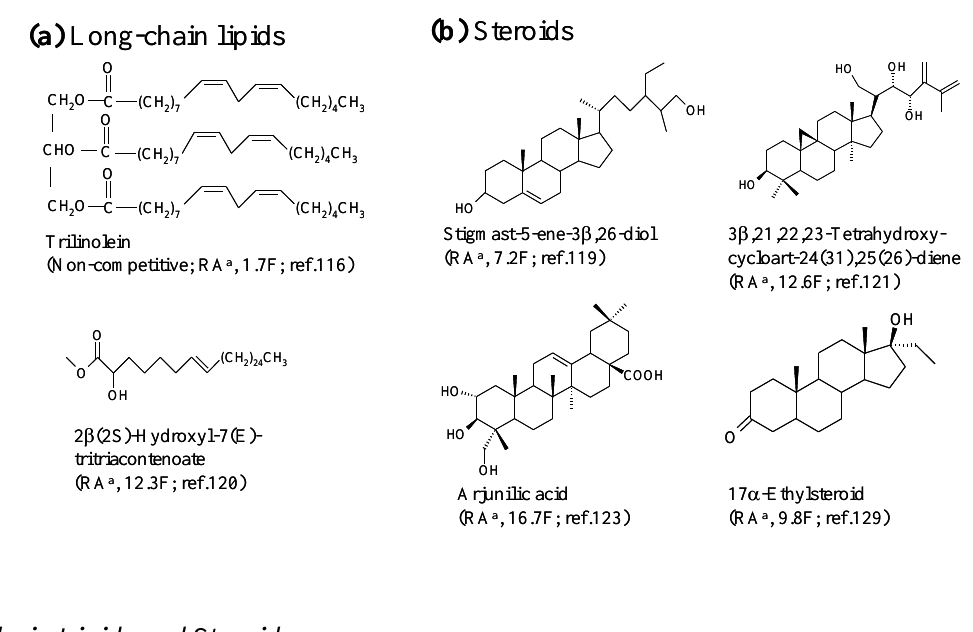
Figure 5. Chemical structures of selected tyrosinase inhibitors belonging to long-chain lipids (a) or steroids (b). RA a and RA b have the same meanings as those of Figure 3. (a) Long-chain